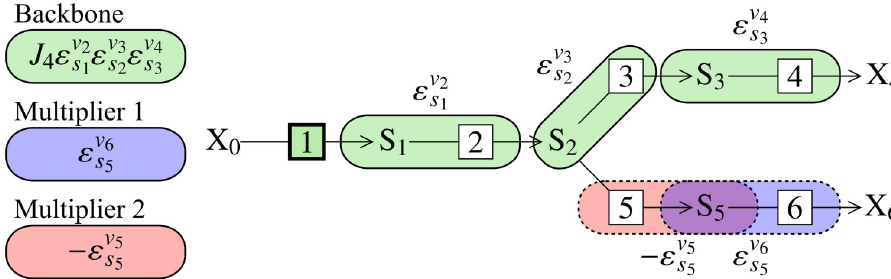
Fig 1. Control patterns for a 6-step branched metabolic pathway. Backbone and multiplier patterns for two control patterns of C J 1 are depicted. Green bubbles indicate the backbone pattern, while red and blue bubbles each 1 indicate a different multiplier pattern. Each multiplier-backbone combination (Backbone × Multiplier 1 and Backbone × Multiplier 2) represents a single control pattern. The chain of local effects for the backbone originates from a perturbation of v 1 , which, if positive, causes an increase in s 1 , which increases v 2 , then s 2 , then v 3 , then s 3 , and, finally, v 4 ; each of these effects plays a role in determining the sensitivity of J 1 towards reaction 1 through the backbone, which in turn is modified by one of the two multiplier patterns.